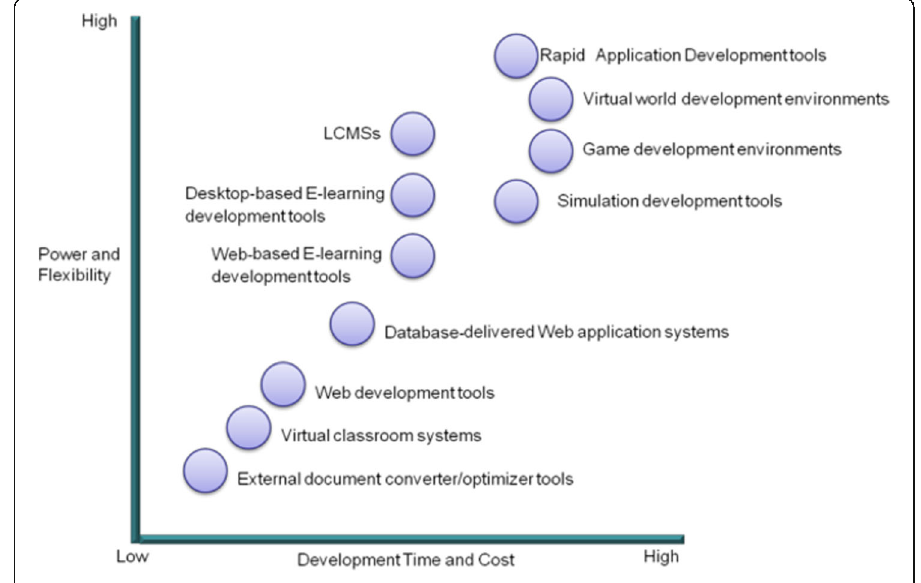
Fig. 1 Categories of authoring tools according to ADL